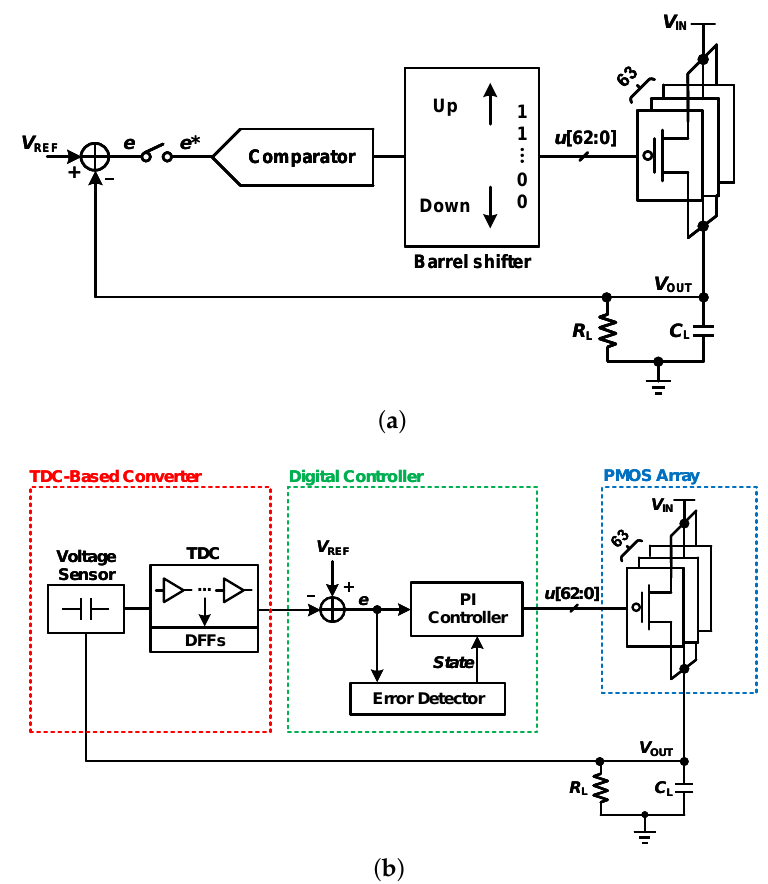
Figure 1. The circuit architecture of ( a ) the baseline D-LDO and ( b ) the proposed